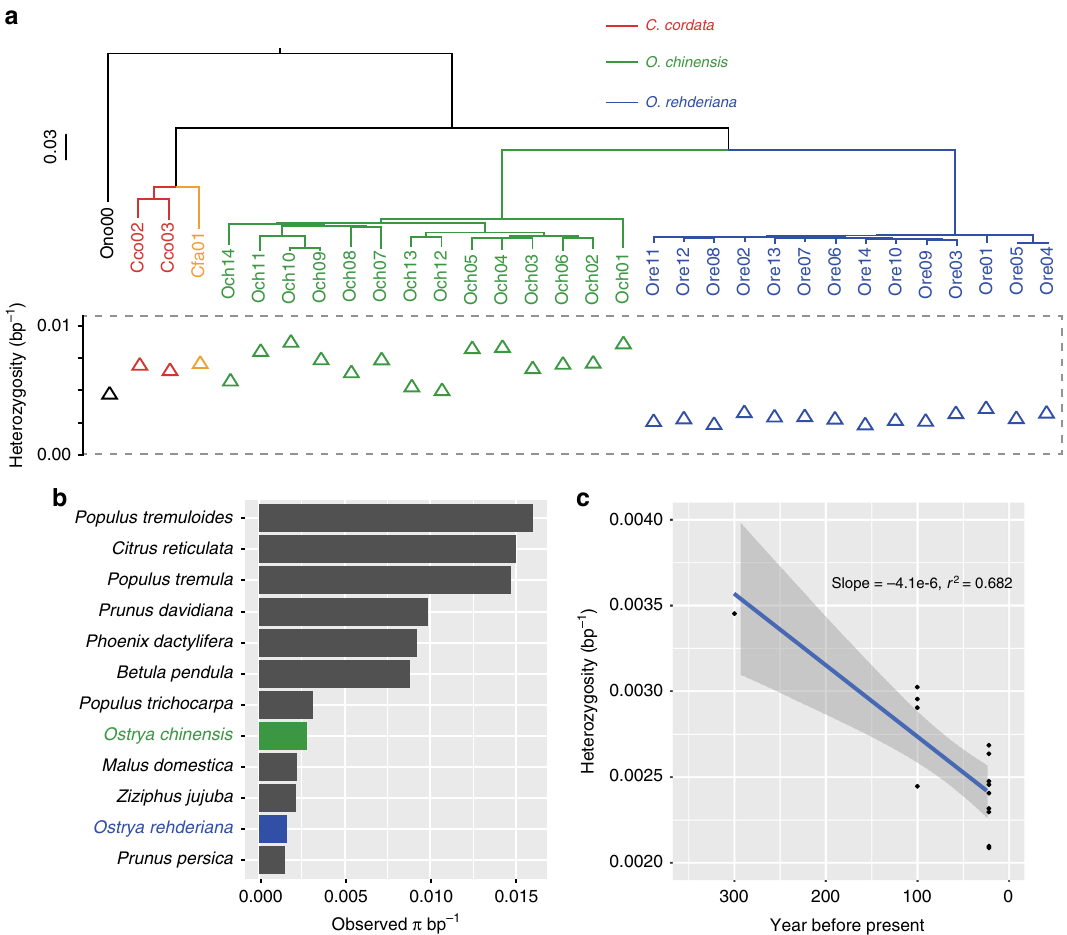
Fig. 3 Phylogenetic and genetic diversity for O. rehderiana and O. chinensis . a A neighbor-joining phylogenetic tree constructed using whole-genome SNP data: O. rehderiana (blue), O. chinensis (green), C. cordata (red), C. cordata (yellow), and O. nobilis (black). b Genome-wide sequence diversity ( π ) for 12 tree species. c Genome-wide observed heterozygosity for each individual of O.